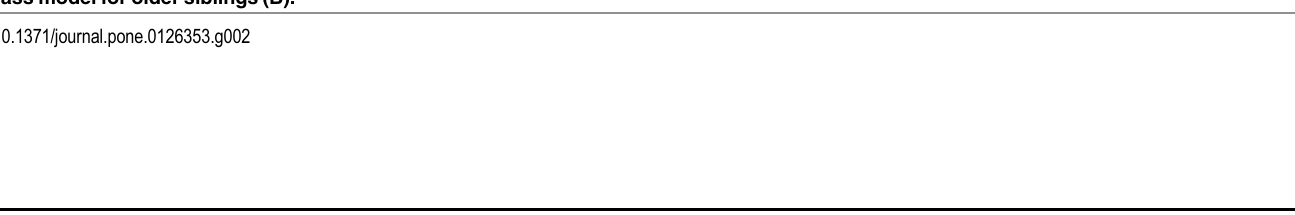
PLOS ONE | DOI:10.1371/journal.pone.0126353 May 21,